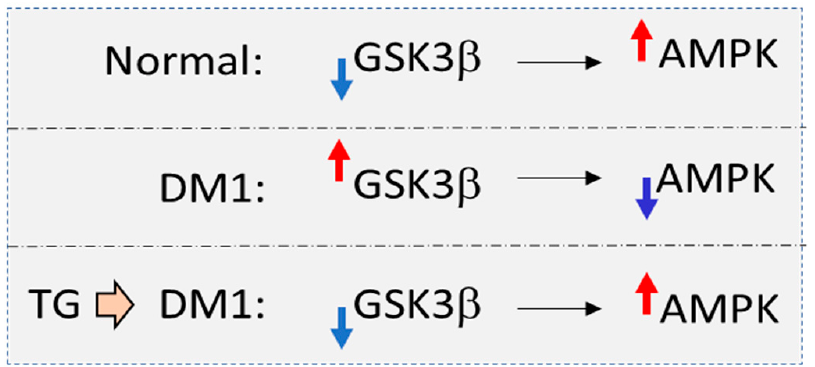
Figure 3. Possible involvement of GSK3 β kinase in the regulation of AMPK in DM1. In normal cells, high levels of active AMPK are maintained by the low levels of GSK3 β activity. However, in DM1 cells, GSK3 β is elevated. Since AMPK is a substrate of GSK3 β , the increase in GSK3 β may lead to a reduction in AMPK in DM1 cells. It is expected that the correction of GSK3 β activity with tideglusib (TG) in DM1 cells might normalize levels of AMPK.